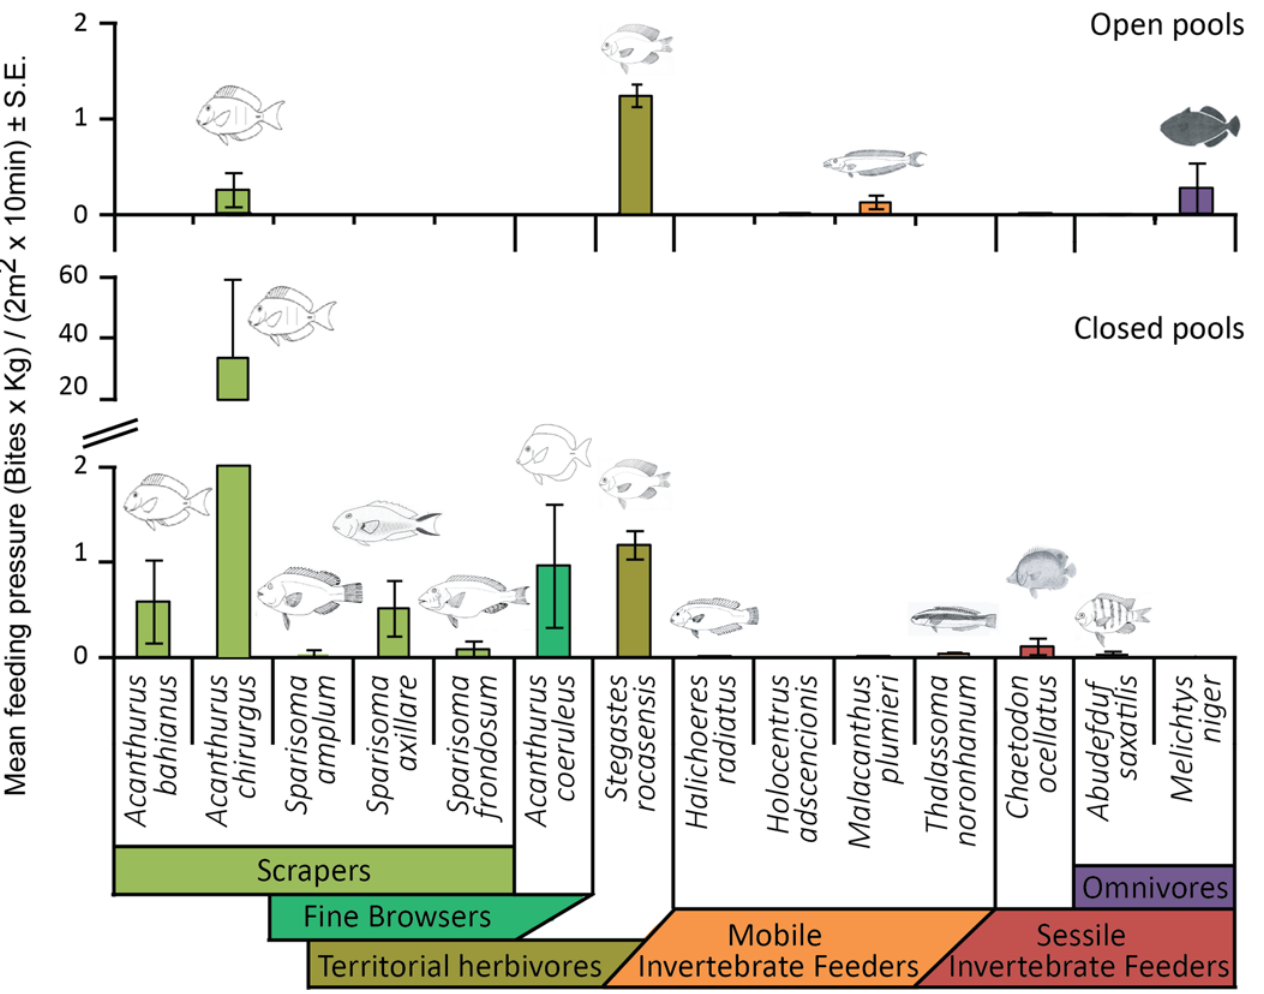
Fig 7. Reef fish feeding pressure on the benthos in closed and open pools. Colored bars indicate species functional groups. Error bars represent standard errors.